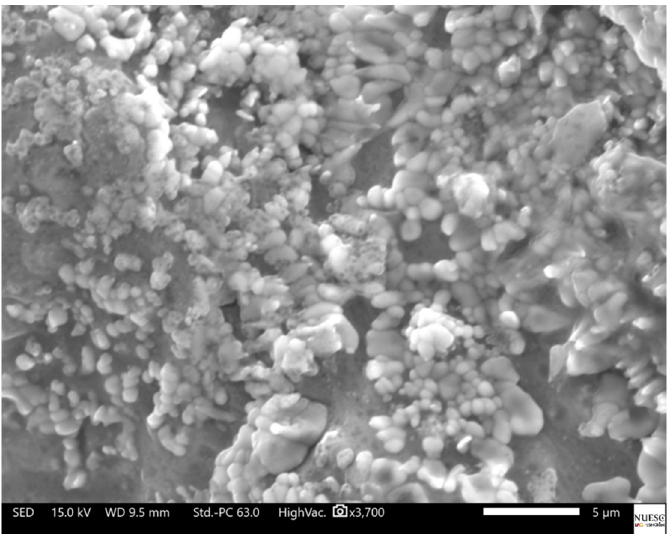
Figure 8. Scanning electron microscopy of silver nanoparticles synthesized with I. fumosorosea extract and 3 mM silver nitrate.